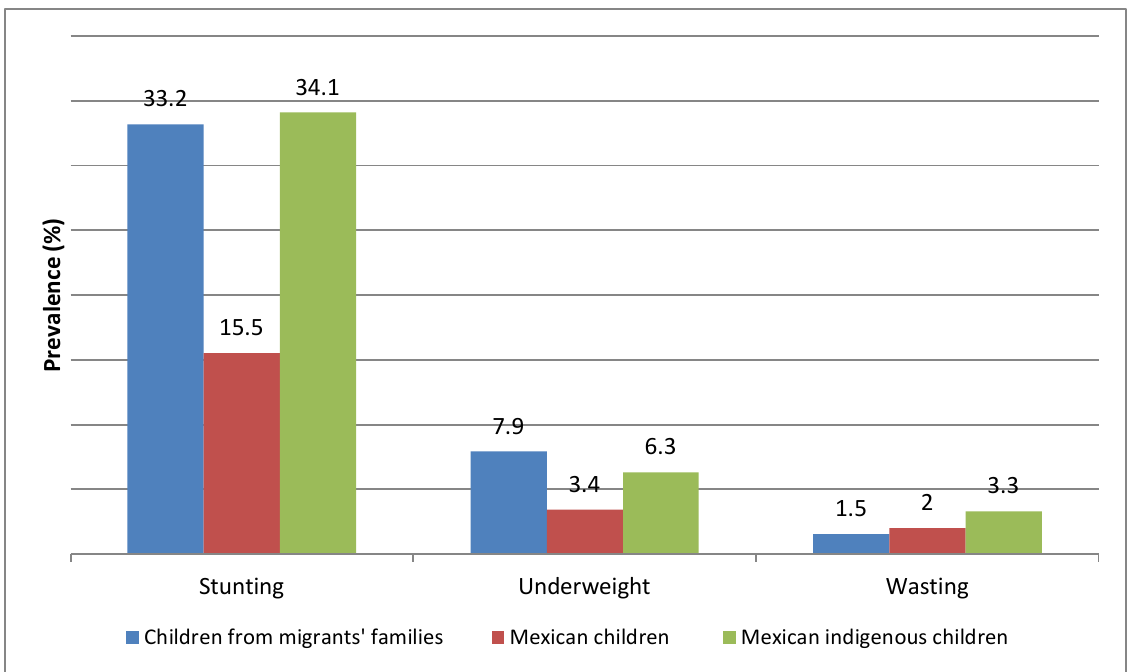
Figure 1. Prevalence of stunting, underweight and wasting in children (<5 years old) from migrants’ families in Northwest Mexico compared with overall Mexican Children and Mexican indigenous children in the 2006 national survey.